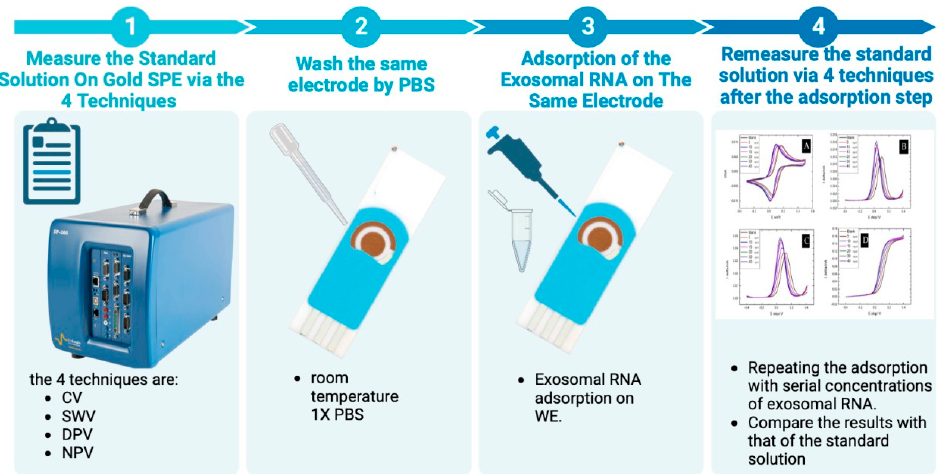
Figure 11. A diagram showing the procedure for measuring the e ff ect of exosomal RNA adsorption on the Au electrode surface, using the standard K 4 [Fe(CN) 6 ]/K 3 [Fe(CN) 6 ] electrochemical reaction.